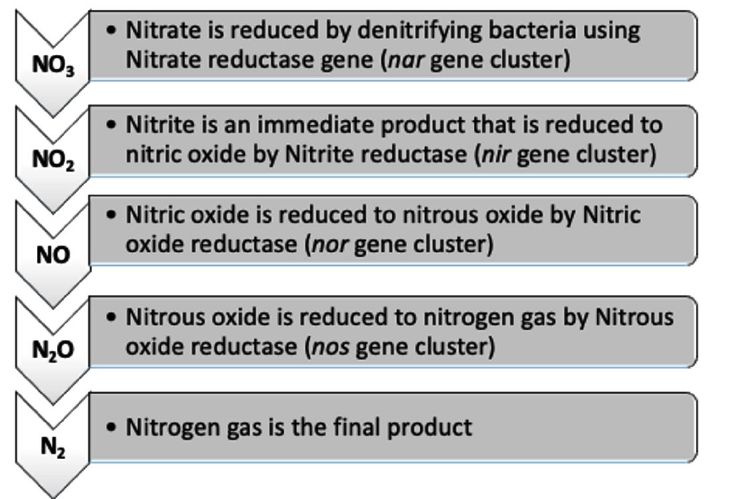
Fig.1. The denitrification pathway by denitrifying bacteria. it is a reduction process where the NO3 is reduced and converted to nitrogen gas through series of chemical